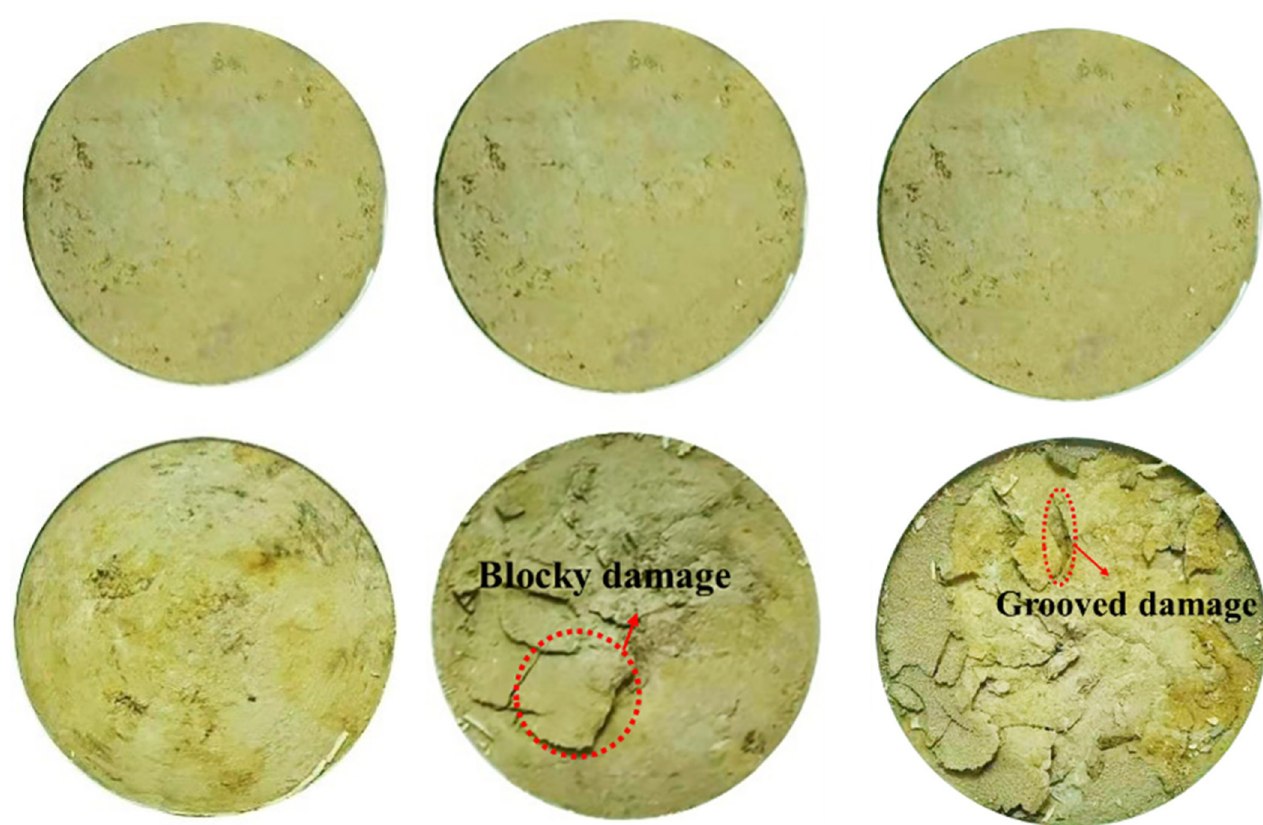
Fig 4. Comparison of the shear surface morphology of 1 # - 3 # undisturbed loess specimen before and after the test. (A ) 1 # v = 0.1 mm / min. (B) 2 # v = 1.0 mm / min. (C) 3 # v = 5.0 mm / min.